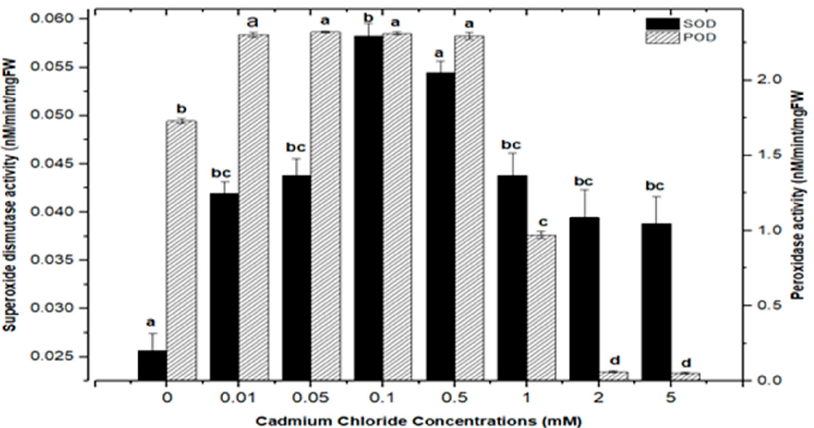
Figure 12. Superoxide dismutase and peroxidase activity of F. indica calli elicited with seven different concentrations of cadmium chloride along with control. Bars labeled with different letters (LSD values) exhibit significant variation ( α < 0.05).